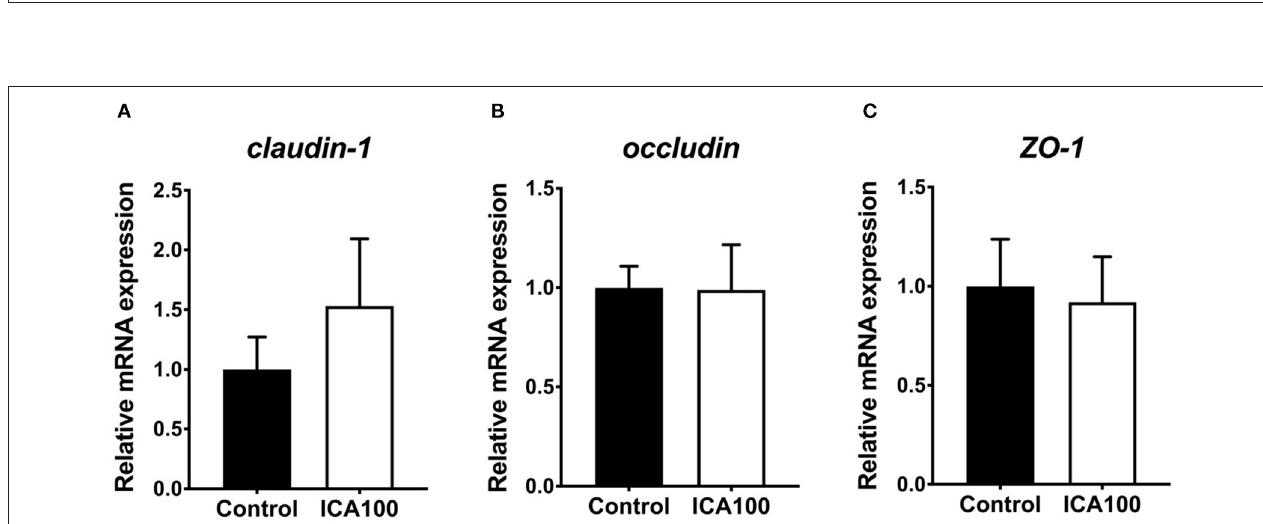
Frontiers in Nutrition |